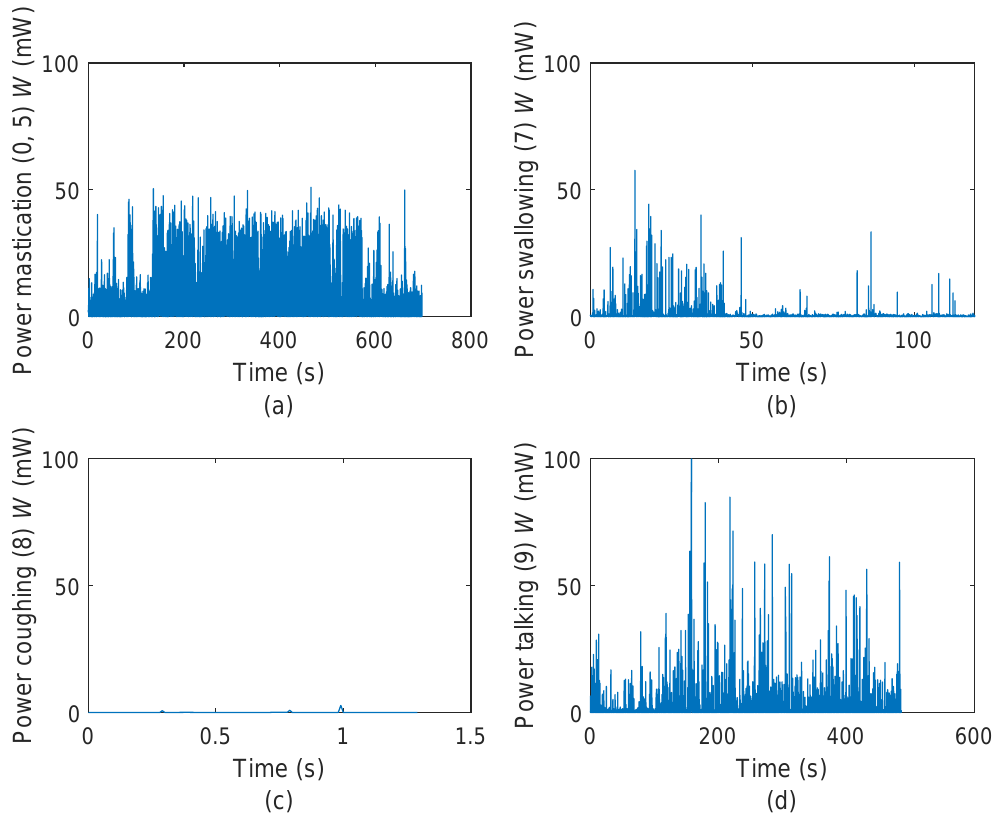
Figure 6. Instantaneous power associated with each jaw joint activity detected by the internal sound detection algorithm for one test subject: ( a ) chewing, ( b ) swallowing, ( c ) coughing, ( d )